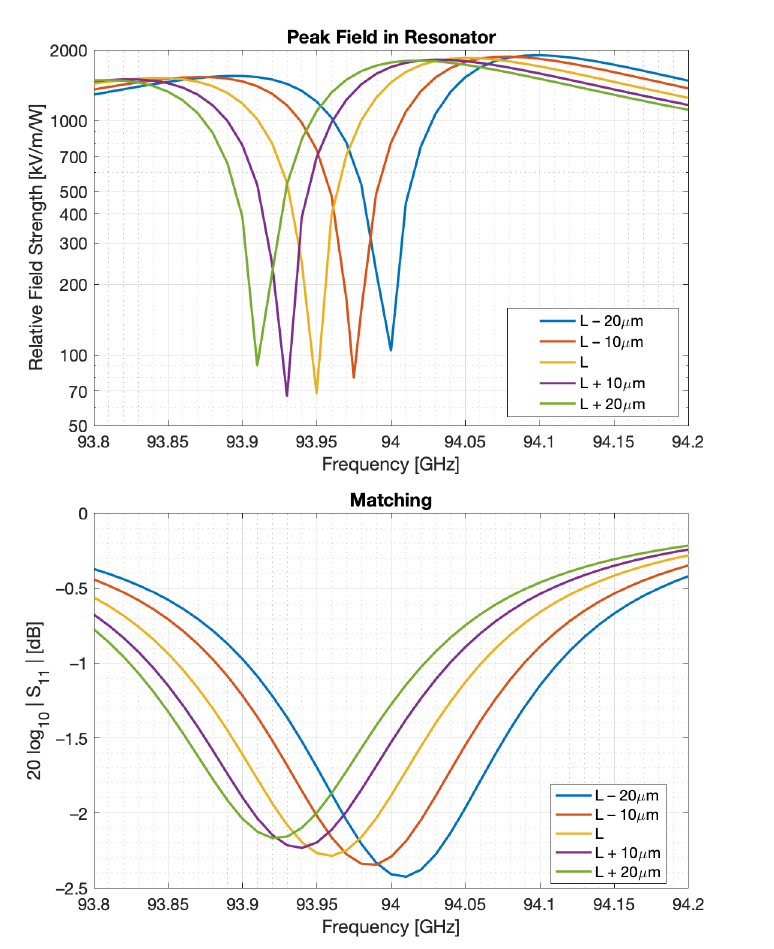
Figure 5. Simulated relative field strength approximately 2 µ m inside the WGM receiver as a function of frequency for various positions of the matching stub. The field strength is described relative to the power (in Watts) at the input. The matching, S 11 , of the resonant modulator is also shown.